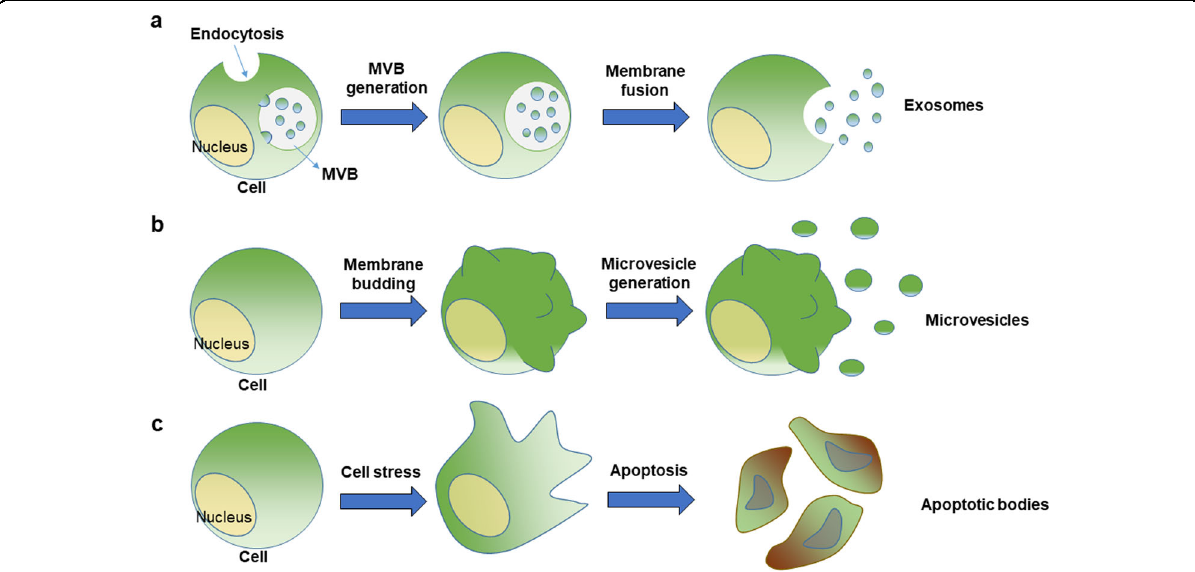
Fig. 2 Generation mechanisms of three types of EVs. a – c The generation processes of exosomes, b microvesicles, and c apoptotic bodies are mechanistically different in mammalian